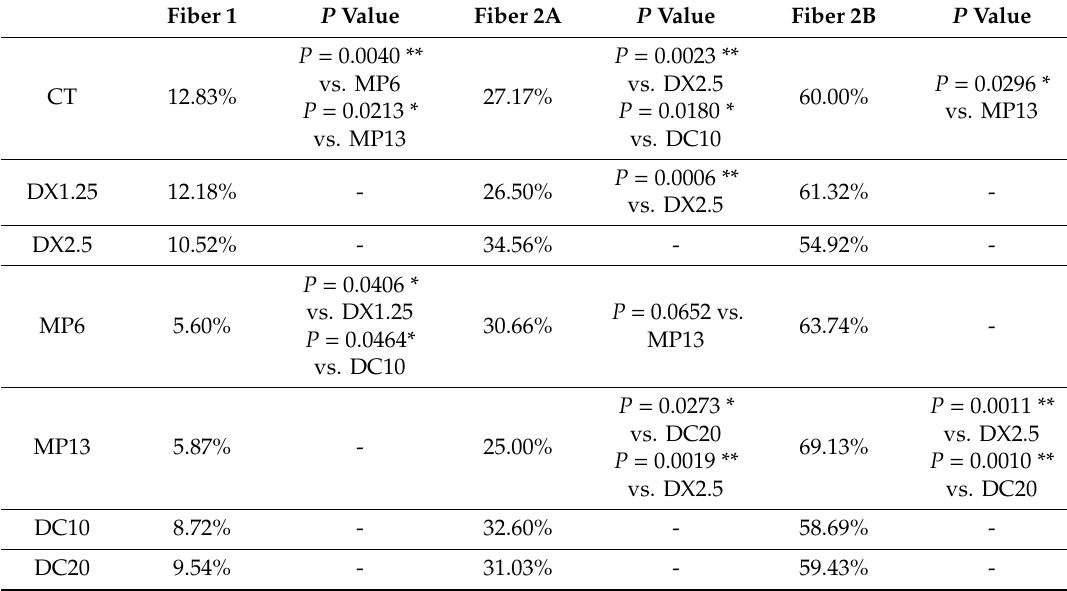
Table 3. Muscle fiber type proportion after administration of di ff erent glucocorticoids. The Mann-Whitney test was used ( n = 5 per